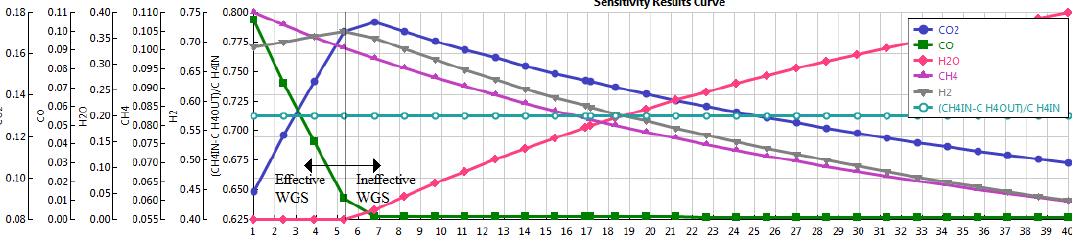
Figure 6. WGS sensitivity results (WGS product molar fractions vs. WGSH2O mass flow rate).